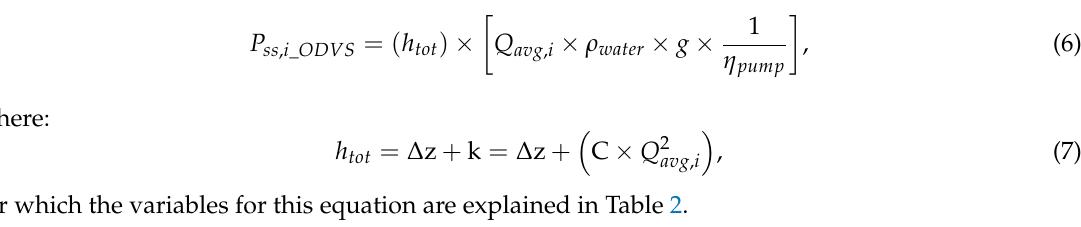
Table 2. Parameters for Equations (6) and (7) specifying parameter, symbol used, value and units used. Parameter Symbol Value Unit Hydraulic Head ∆ z 15 meter Friction Head Loss Coefficient C = 2.51 × 10 8 = Avg . Volume Consumed Avg . Duration Average Flow Rate for Hour Q avg , i Based on REU2016 Data Density of Water Gravitational Constant g 9.81 Pump Efficiency η pump 0.27